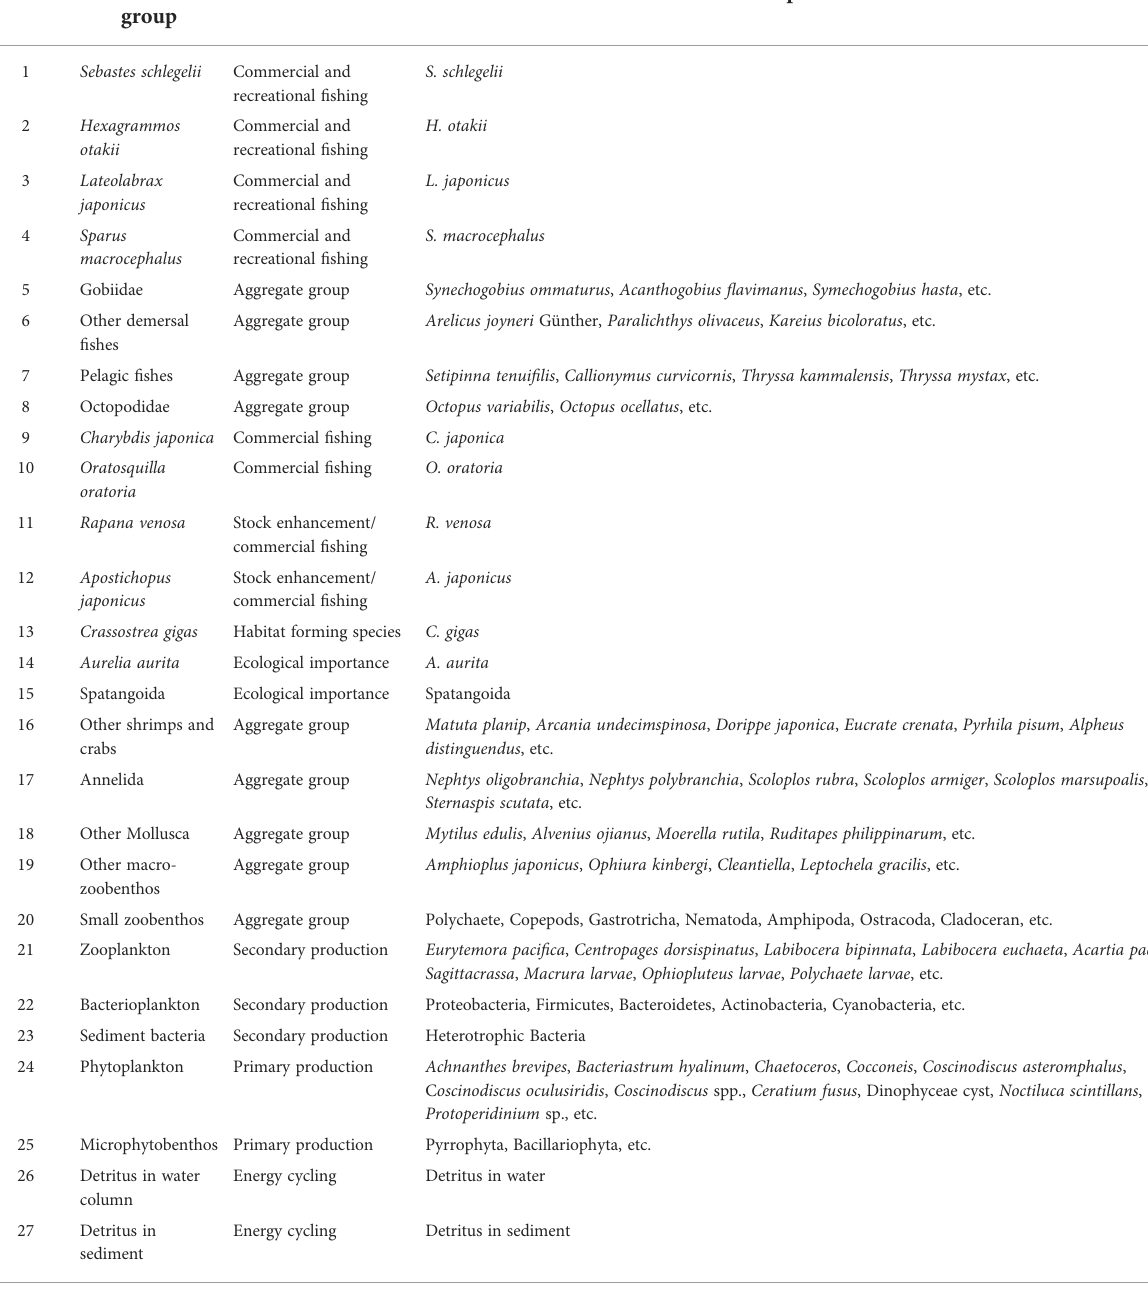
TABLE 1 Functional groups and main species comprising the different model compartments for the steady-state model of the Laizhou Bay marine ranching